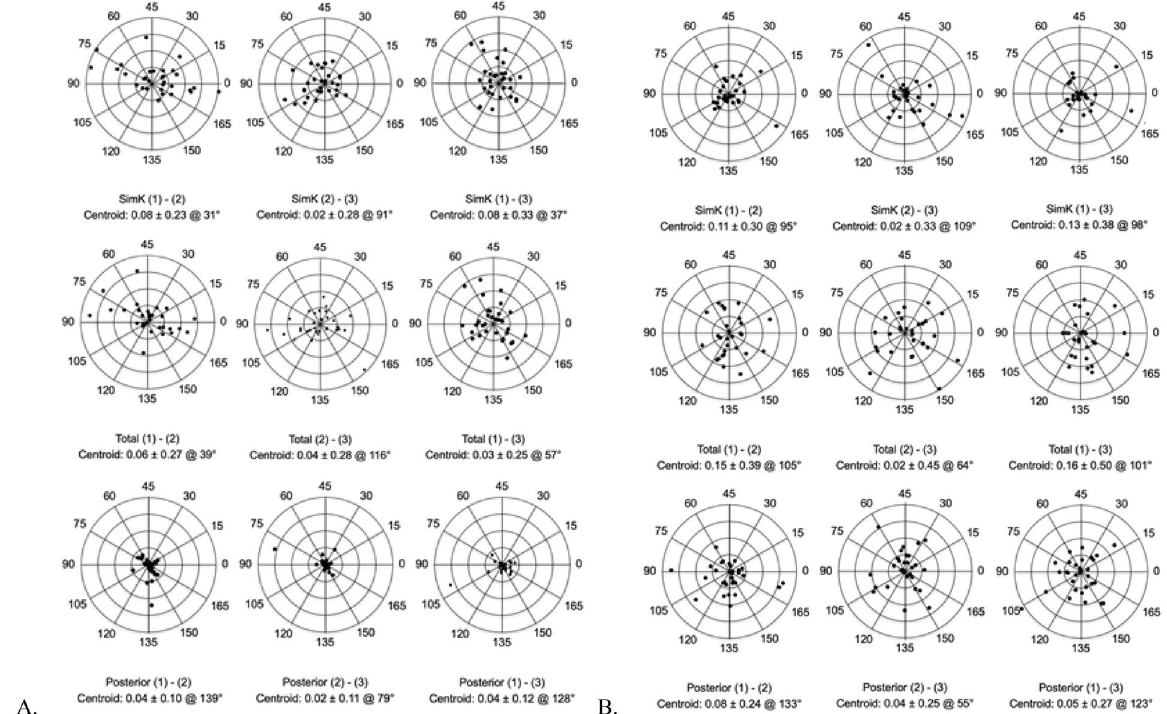
Figure 2. ( A ) Galilei and ( B ) Cassini, For post-refractive eyes, double-angle plots showing intrasubject differences in simulated keratometric (SimK) (top row), total (middle row), and posterior corneal astigmatism (bottom row) measurements. Each ring represents 0.25 diopters (D), and the outer ring represents 1.0